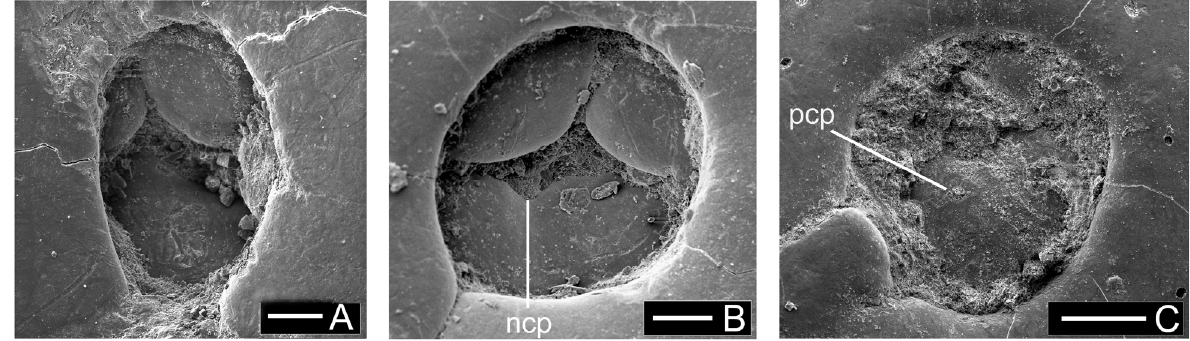
Fig. 5. A , B , Tremataspis rohoni Robertson; C , Tremataspis rohoni ? Robertson. Locations : A, B, GIT 846-12; C, GIT 846-10, Elda Cliff, bed IV; Kuusnõmme Beds of Rootsiküla Regional Stage, Homerian, Upper Wenlock, Lower Silurian. Scale bars = 50 µm (A, B); 100 µm (C). Abbreviations : ncp, notch in a covering platelet; pcp, large pore in a covering